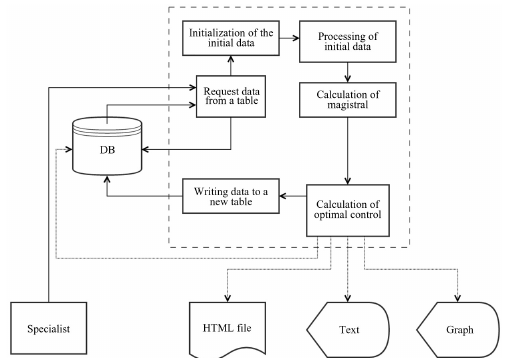
Fig. 1. The scheme of the information system